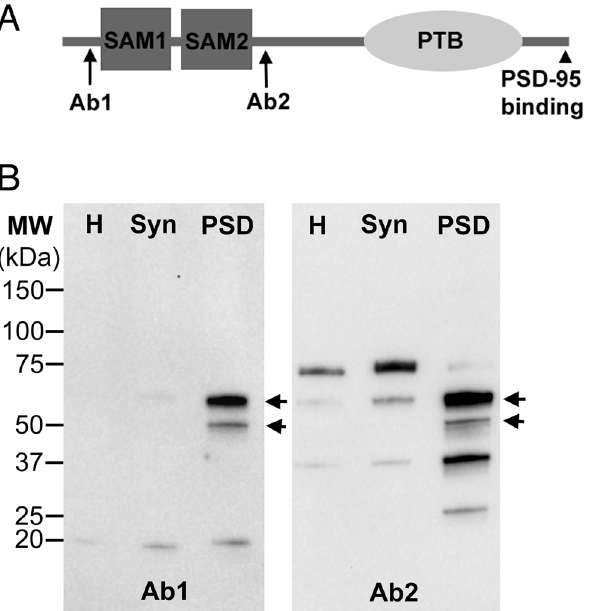
Fig 1. (A) The short AIDA-1 proteins (P0C6S7-2 or AIDA-1e, P0C6S7-3 or AIDA-1d in rat as designated in UniProt) contain two SAM domains and a PTB domain, but lack the characteristic ankyrin repeats of the long form (P0C6S7-1, 139 kDa). Antibody 1 (Ab 1) and antibody 2 (Ab 2) were raised against peptides corresponding to epitopes near the N-terminal and near SAM2 domain respectively (arrows). PSD-95 binding is at the C-terminal (arrowhead). (B) Western immunoblots using the two antibodies. Homogenate (H) and synaptosome (Syn) fractions containing 10 μ g protein and PSD fractions containing 5 μ g protein were applied to each lane. Positions of ~50 kDa and ~60 kDa bands recognized by both antibodies are shown by